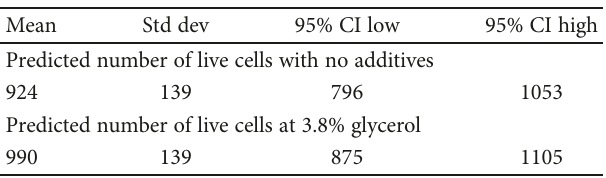
Table 8: Predicted number of live cells using the Design-Expert Point Prediction